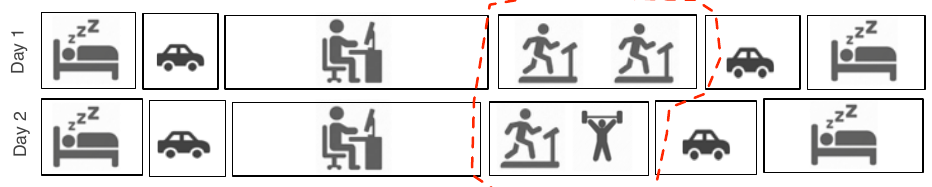
Figure 2. A presentation of constrasting activities bewteen two evetns of the gym cluster (the cluster is marked with red dotted area), i.e., cardio training and weight